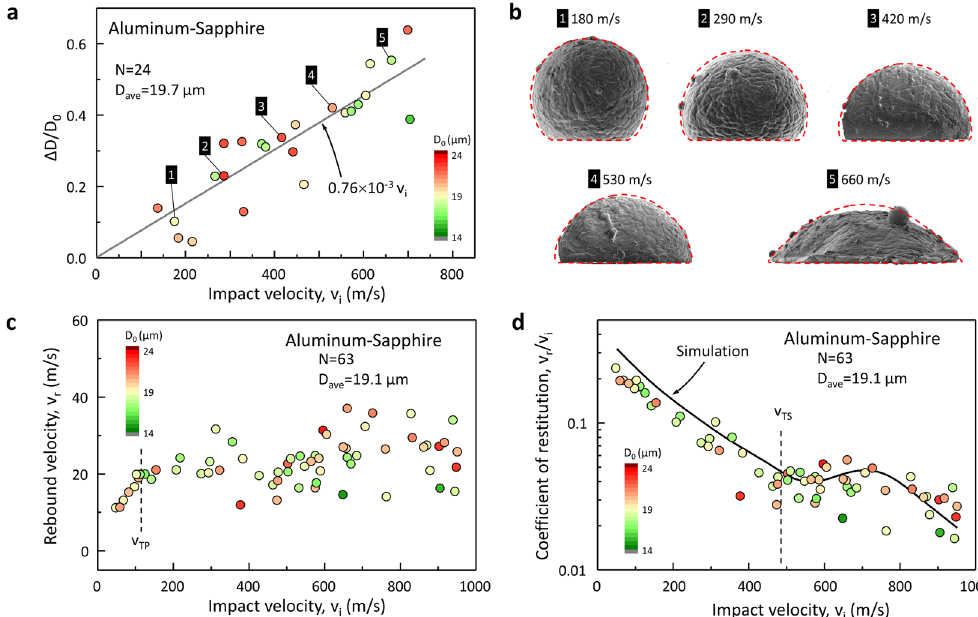
Figure 2. The in situ and postmortem characteristics of aluminum particles. ( a ) The specific change of diameter ( Δ D / D 0 ) depending on impact velocities is plotted with a linear fitting line. ( b ) Five representative SEM images and outlines of numerically-simulated deformed particles (red dashed lines). ( c ) Rebound velocity of aluminum particles in Al-sapphire collision. ( d) Coefficient of restitution of aluminum particles in Al-Sap collision with FE simulation results for 19 µ m diameter